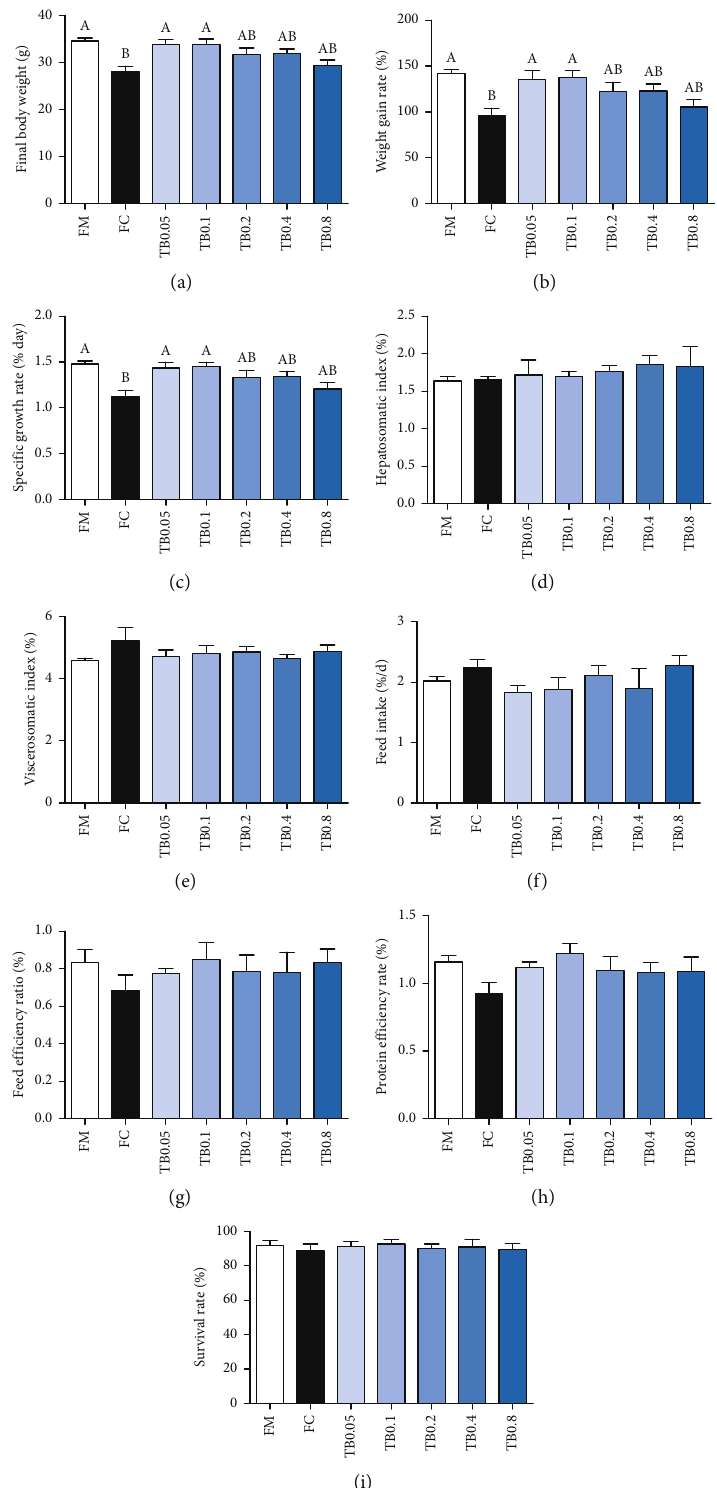
Figure 1: E ff ects of tributyrin supplementation on survival and growth performance of juvenile large yellow croaker fed diets with high level of Clostridium autoethanogenum protein replacing fi sh meal. Values are means ( n = 3 ), with the vertical bars represent the standard error. Data in bars sharing the common letters indicated no signi fi cant di ff erence determined by Tukey ’ s test ( P > 0 : 05